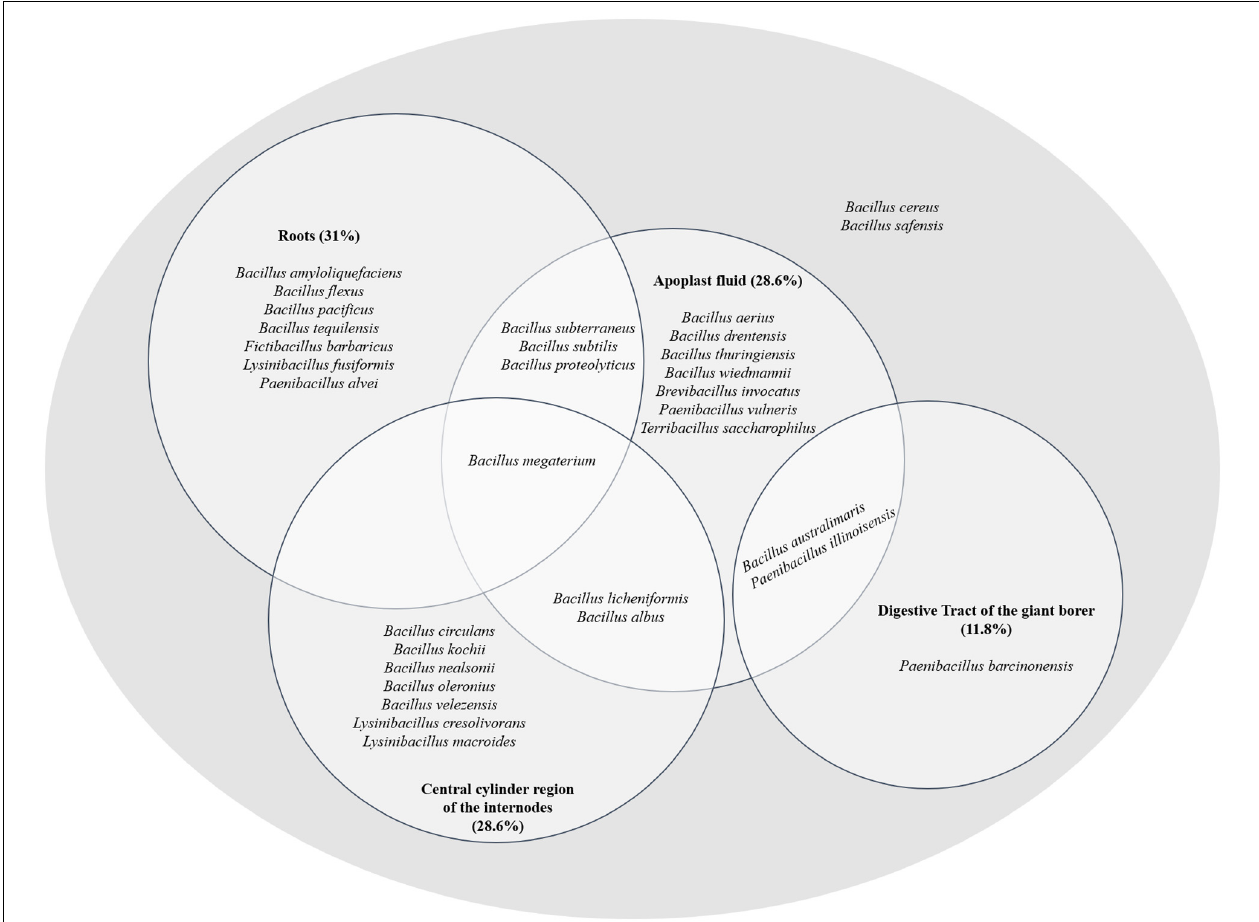
FIGURE 4 | Species phylogenetically identified in the different sugarcane niches (apoplast, central cylinder region of the internodes and roots) and in the digestive tract of the giant borer ( Telchin licus licus ). The diagram shows species inhabiting different